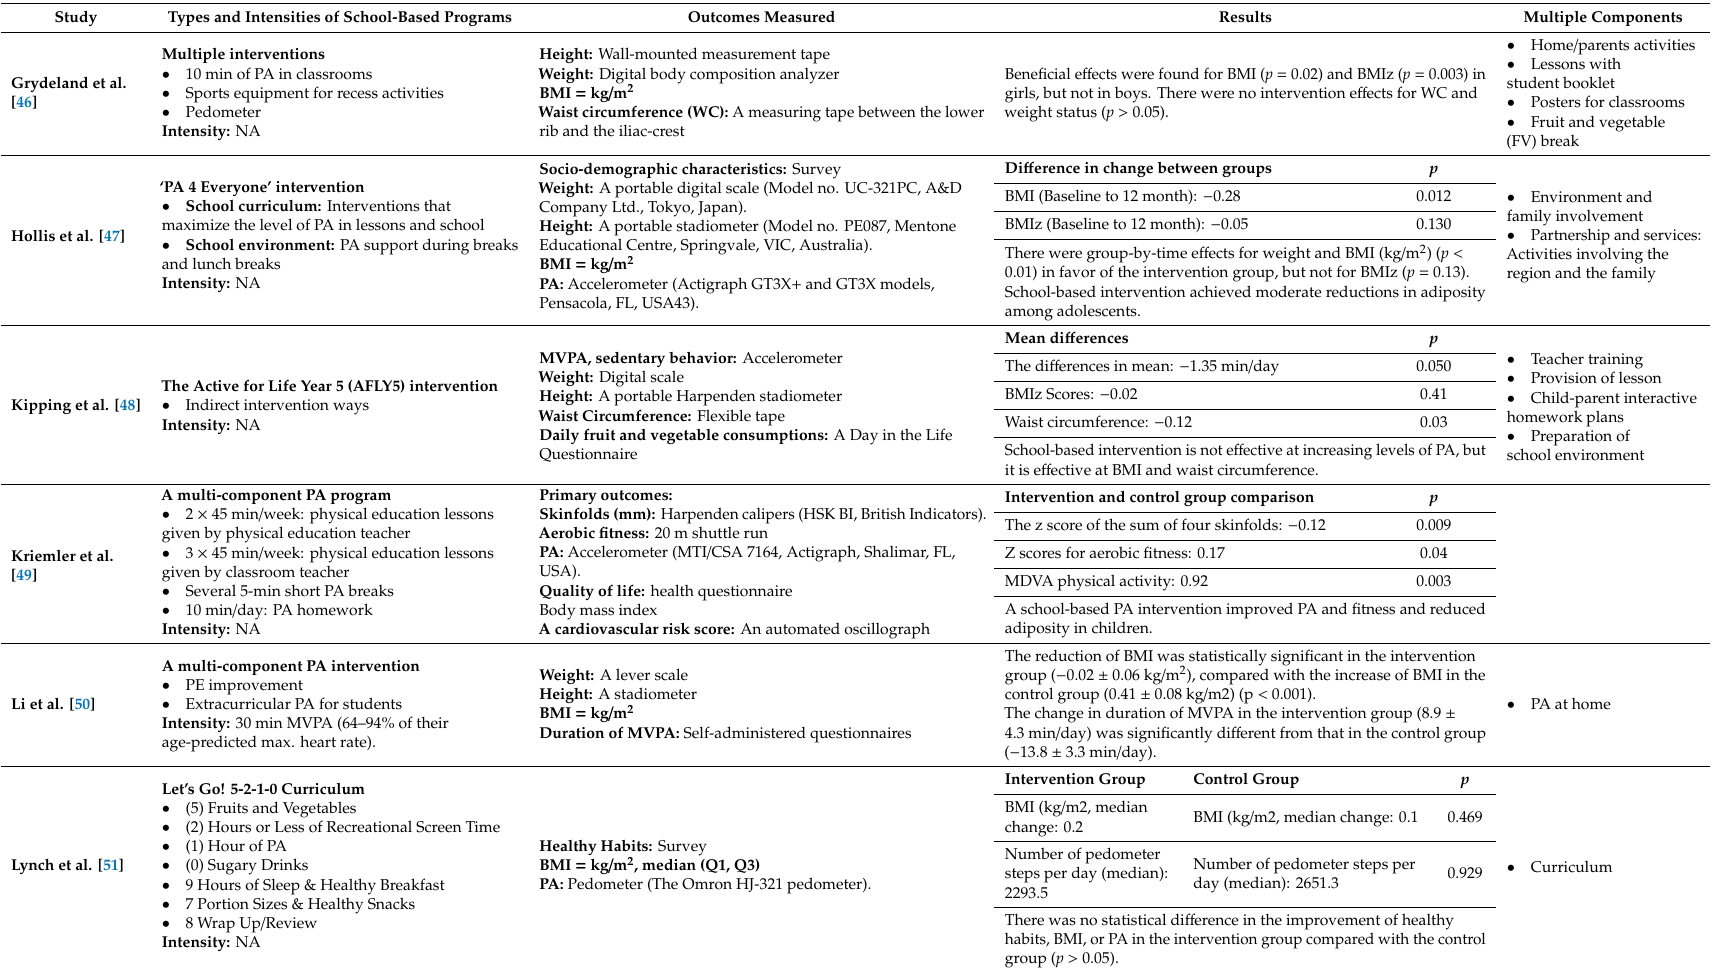
Weight: A lever scale Height: A stadiometer BMI = kg / m 2 Duration of MVPA: Self-administered